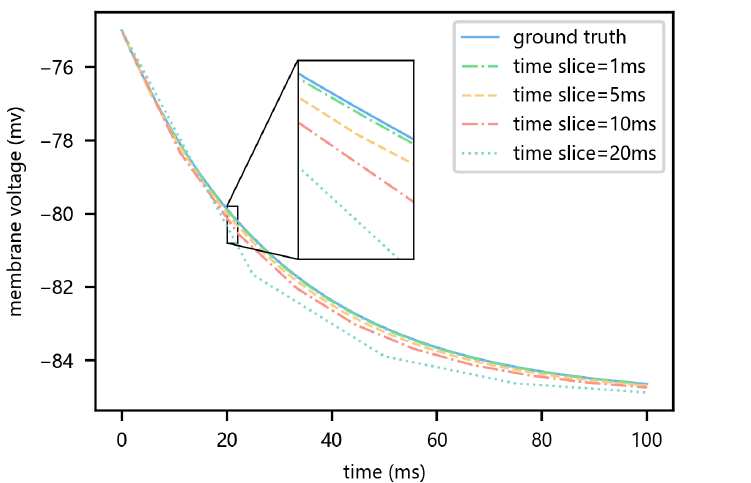
Figure 1. Accuracy comparison of clock-driven models under different time